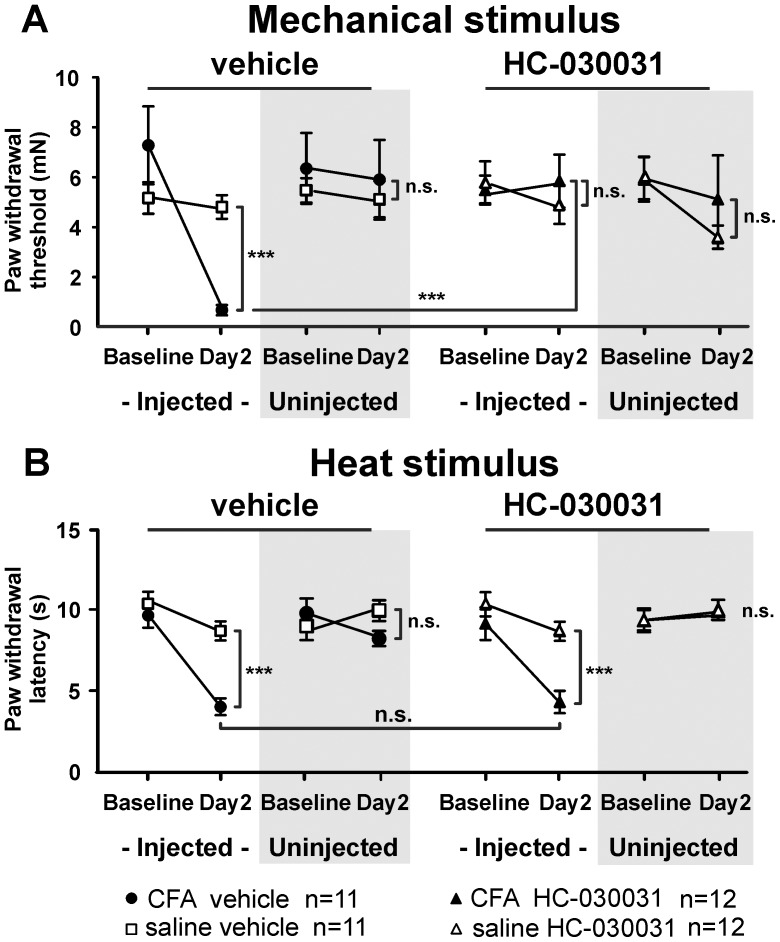
A TRPA1 antagonist, HC-030031, alleviates mechanical hyperalgesia.Treatment groups were divided into CFA+vehicle, saline+vehicle, CFA+HC-030031 and saline+HC-030031 (100 µg HC-030031 in vehicle). A, Mechanical paw withdrawal threshold for each group in the injected paw (white) and uninjected paw (grey). B, Thermal paw withdrawal latency for each group in the injected paw (white) and uninjected paw (grey). *, two-way ANOVA followed by a Bonferroni post-hoc test of all four groups.